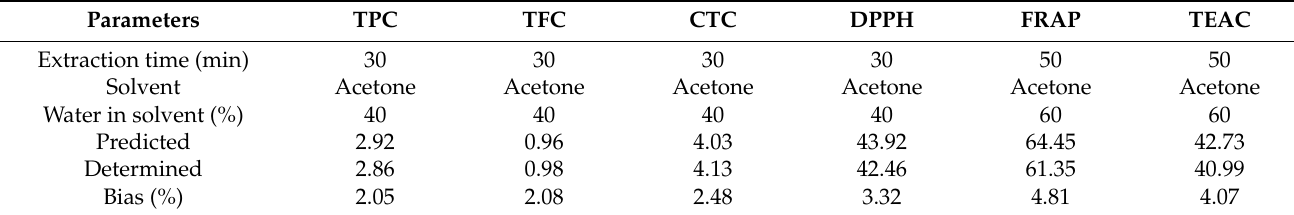
Table 5. Optimum experimental conditions for improved recovery of bioactive compounds with increased antioxidant activity from walnut flower extracts.